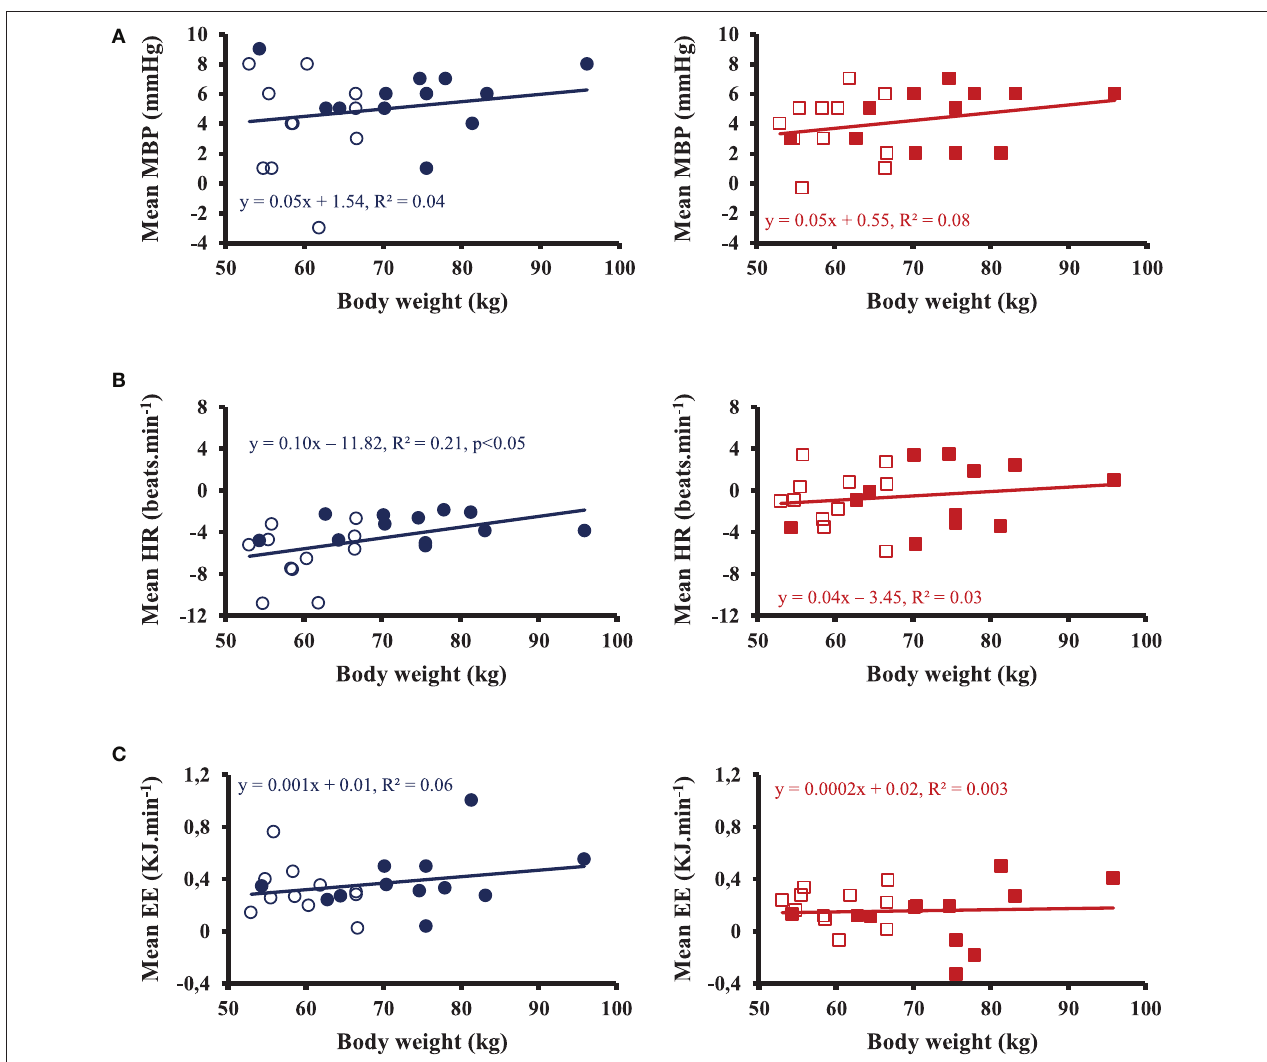
FIGURE 4 | Correlations between mean body weight for 12 men ( (cid:8) , (cid:4) ) and 11 women ( ◦ , (cid:3) ) and mean blood pressure (MBP) (A) , heart rate (HR) (B) and energy expenditure (EE) (C) averaged over 90min post-drink ingestion after drinking cold (Left) and hot (Right) Yerba Mate